Question: Describe this figure in one sentence.
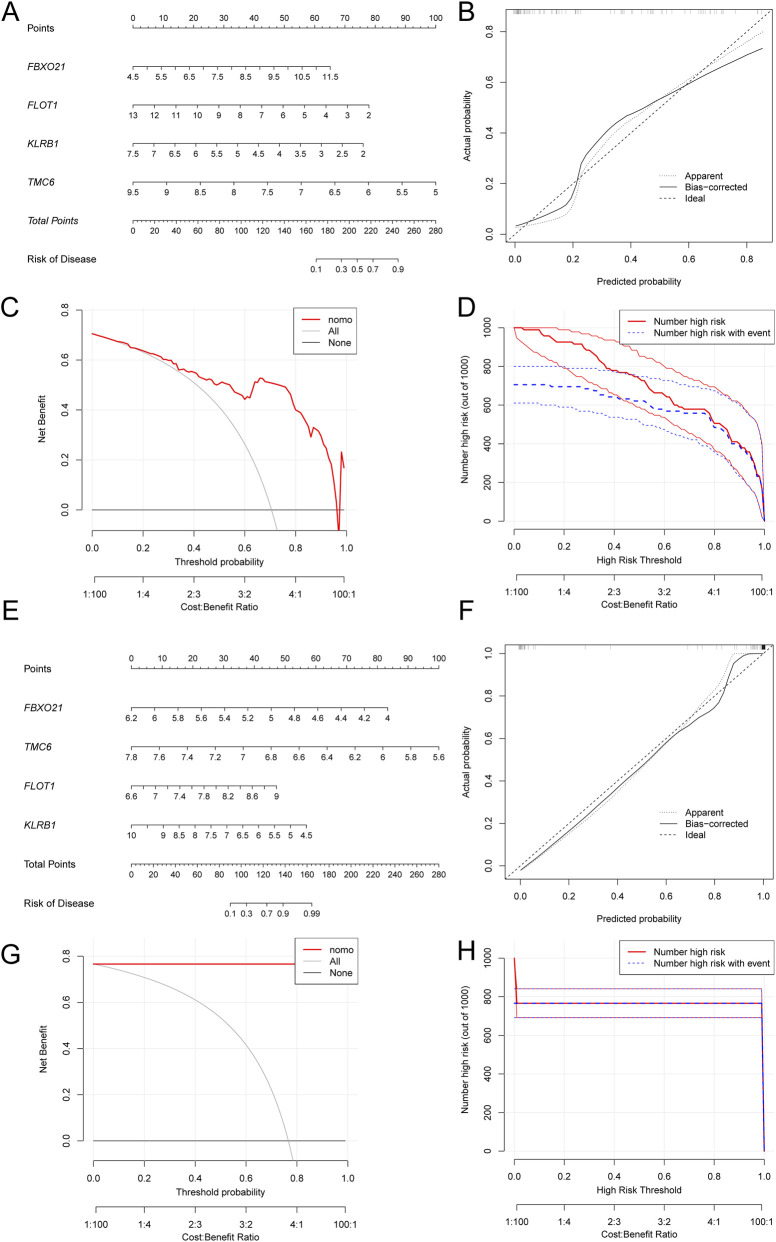
Answer: Construction and evaluation of shared hub gene-based diagnostic nomograms for AKI and sepsis. (A–D) Construction and performance evaluation of the diagnostic model for the AKI group. (A) Diagnostic nomogram constructed using the four identified hub genes ( FBXO21 , FLOT1 , KLRB1 , TMC6 ). Each gene corresponds to specific points on the scale according to its expression level; the total points (sum of individual scores) map to the predicted probability of disease for an individual. (B) Calibration curve assessing the predictive accuracy of the nomogram. The x-axis represents the predicted risk, and the y-axis denotes the actual observed risk. The diagonal dashed line signifies the ideal prediction model, while the solid line represents the bias-corrected performance via bootstrapping; closer alignment between the two indicates superior calibration. (C) Decision Curve Analysis (DCA) evaluating the clinical net benefit. The red curve represents the nomogram model, while the gray and black lines represent the “Treat-all” and “Treat-none” strategies, respectively. (D) Clinical Impact Curve (CIC) assessing the clinical utility of the model. The red curve indicates the number of individuals deemed high-risk by the model at various threshold probabilities, while the blue curve represents the number of true positive cases. (E–H) Construction and evaluation of the diagnostic model for the sepsis group, comprising the nomogram (E) , calibration curve (F) , DCA curve (G) , and CIC (H) .